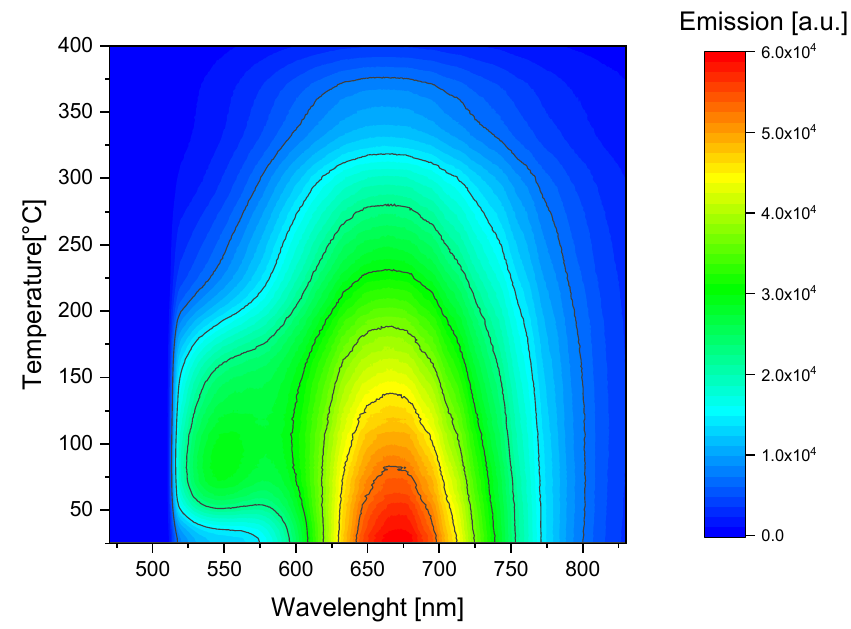
Figure 13. Photoluminescence emission spectra measured while heating the LiF crystal (sample submitted to Method 2). Excitation at 440 nm. The sample was irradiated with Am-241 alpha particles, fluence 10 12 cm − 2 . The spectrum is clipped from the low wavelength side by the applied filter.